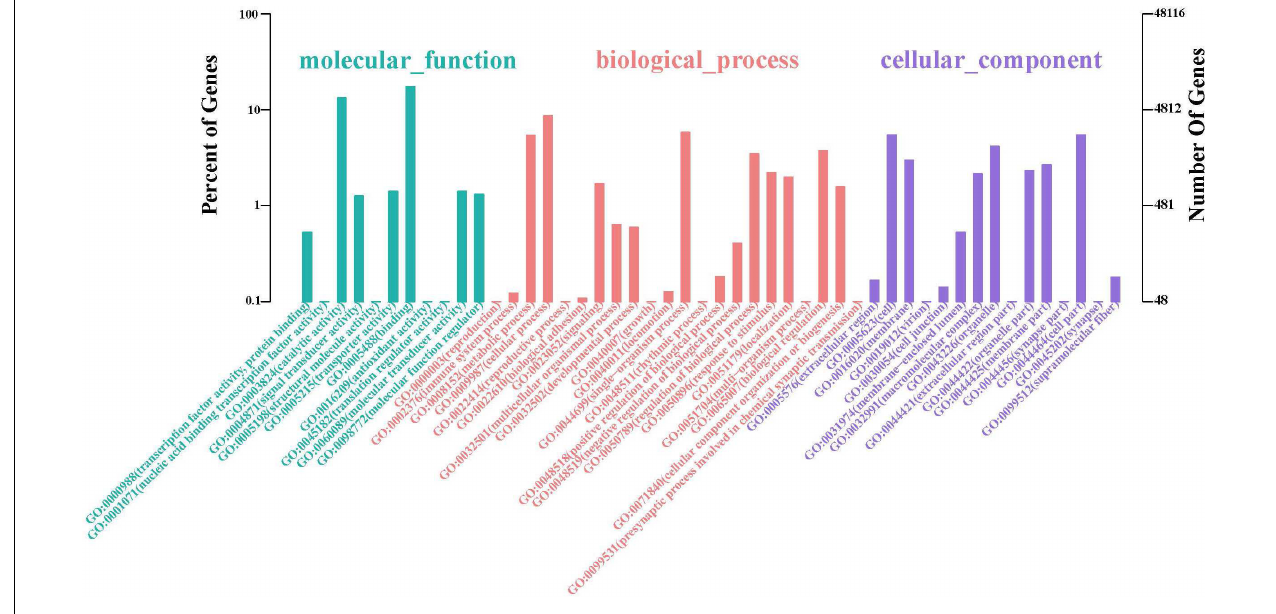
FIGURE 2 | Annotation of unigenes of S. caldwelli from the GO database.